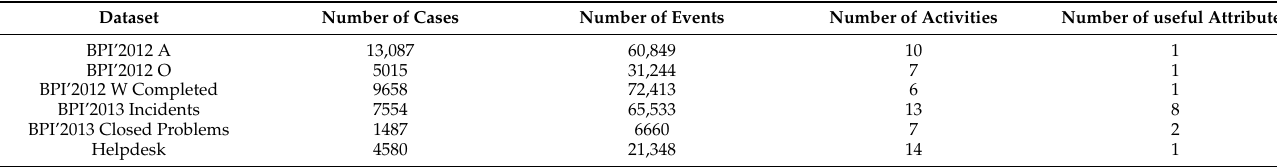
Table 1. Characteristics of the